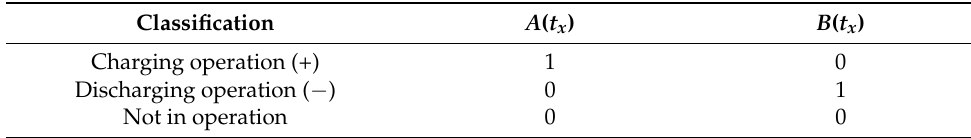
Table 2. Operation signal classification of